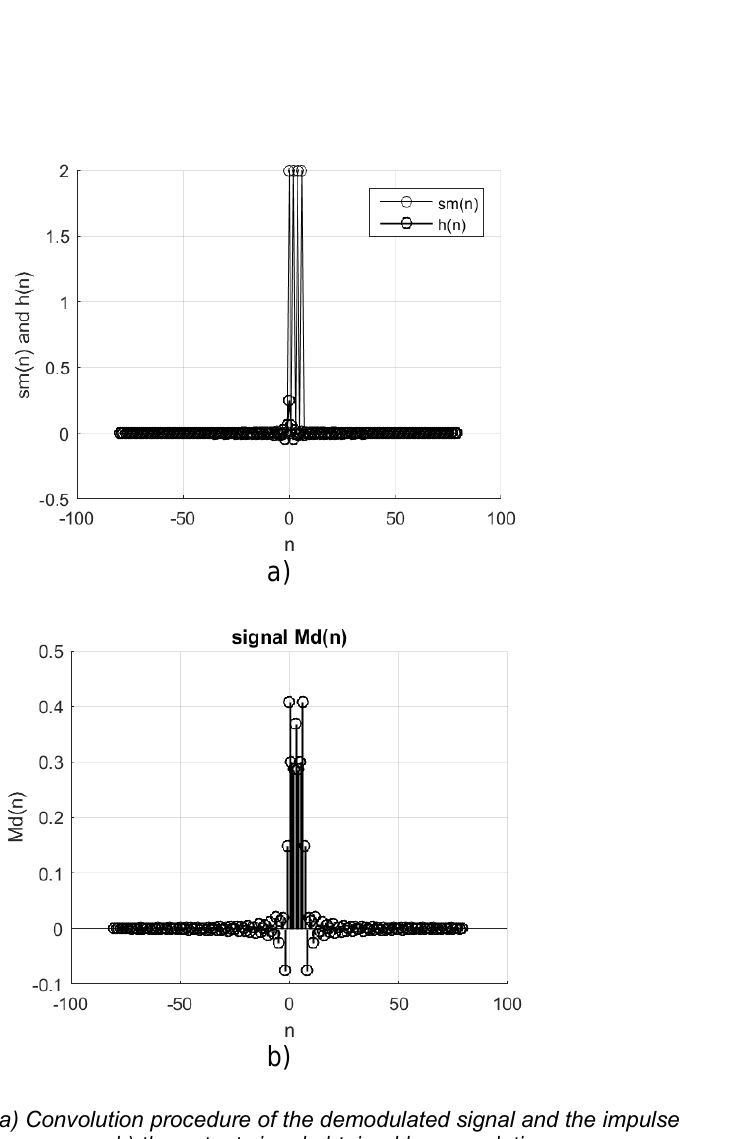
Figure 13 − a) Convolution procedure of the demodulated signal and the